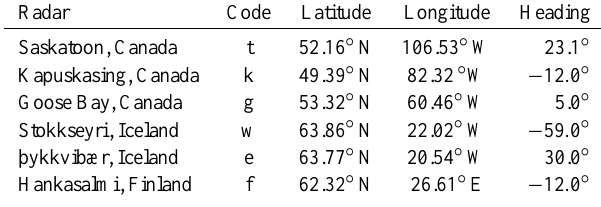
Table 1. The geographic locations and boresite headings clockwise from geographic North of the SuperDARN radars used in this